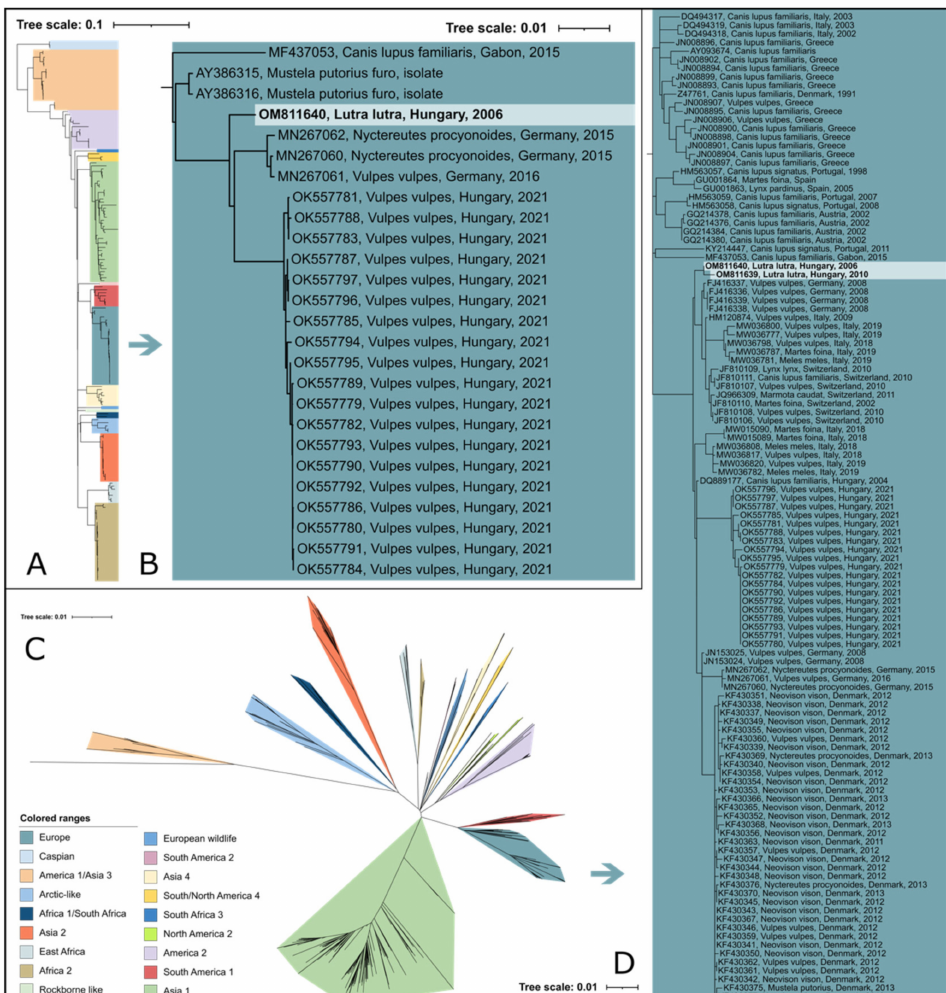
Figure 2. ( A ) Maximum-likelihood phylogenetic tree based on 180 CDV complete-genome nucleotide sequences. ( B ) The European lineage of interest is highlighted in blue color. ( C ) Maximum-likelihood phylogenetic tree based on 843 complete hemagglutinin (H) nucleotide sequences. ( D ) The European lineage of interest is highlighted in blue. Phocine distemper virus (PDV) (GenBank accession number: KY629928) was used as an outgroup to root both phylogenetic